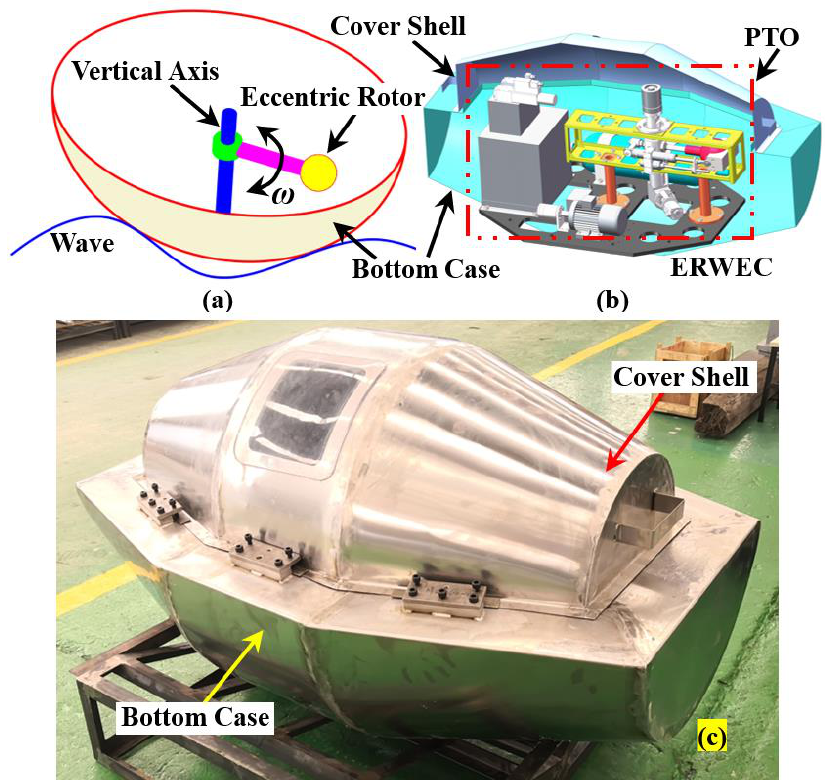
Figure 1. ( a ) The schematic representation of ERWEC, ( b ) 3D schematic diagram of wave energy device, and ( c ) 1:5 scaled model.